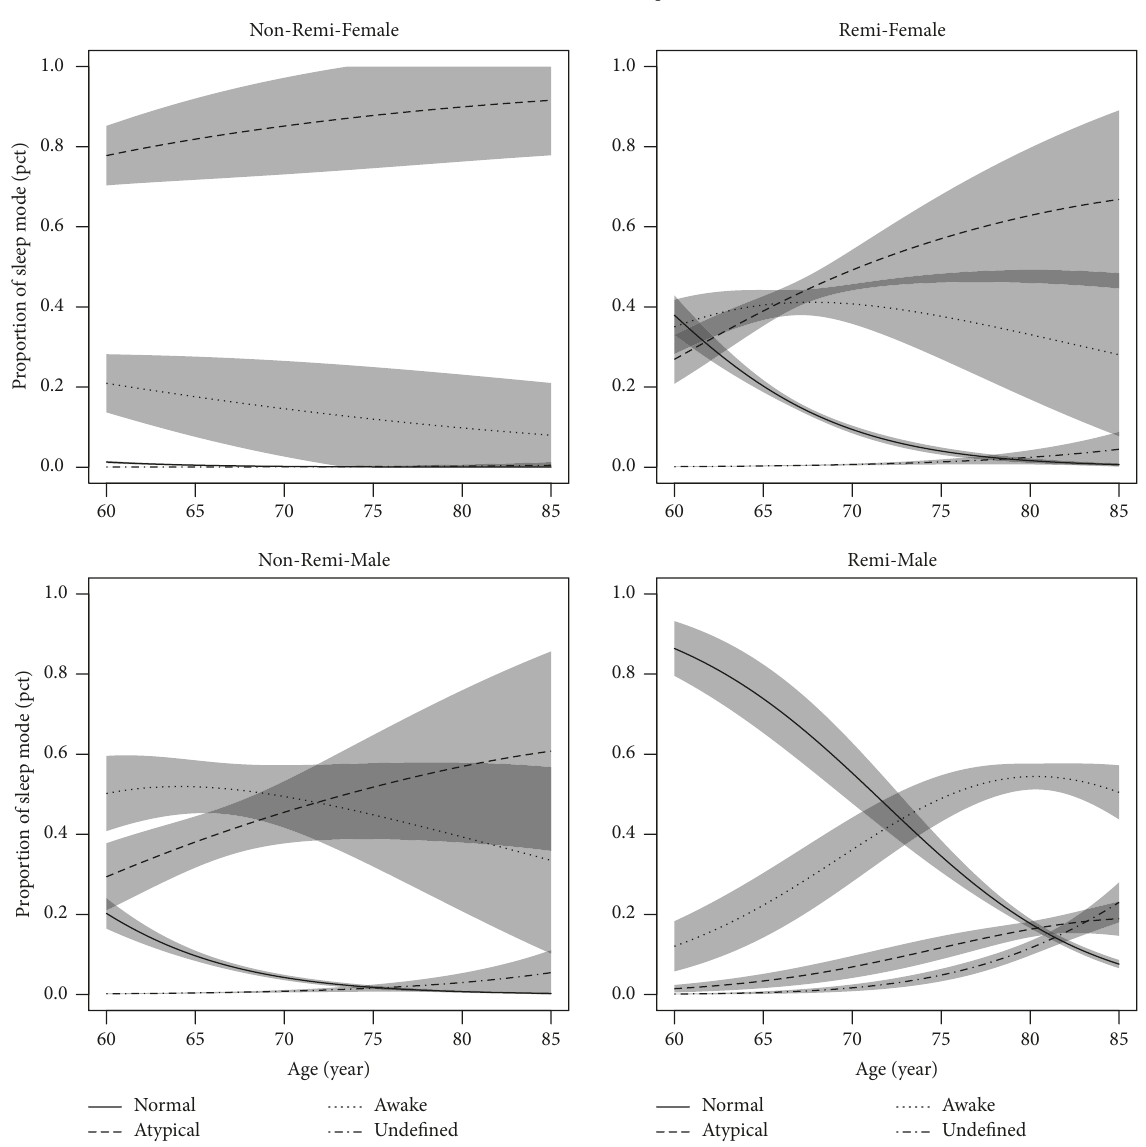
Figure 4: Distribution of sleep modes by gender and remifentanil infusion. All the PSG epochs are classified into 4 groups: normal sleep (AASM standard), atypical sleep (Watson’s classification), awake (wake), and undefined (the epochs with artefacts). The distribution of these groups by gender and remifentanil infusion at different ages is shown on the graph. The grey field represents confidence